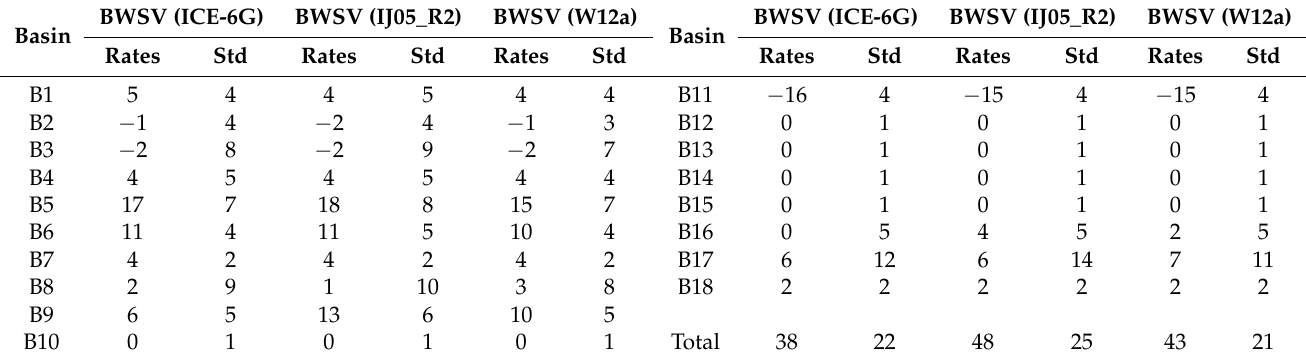
Table 2. Regional BWSV rates in 18 drainage basins and associated standard deviations, in